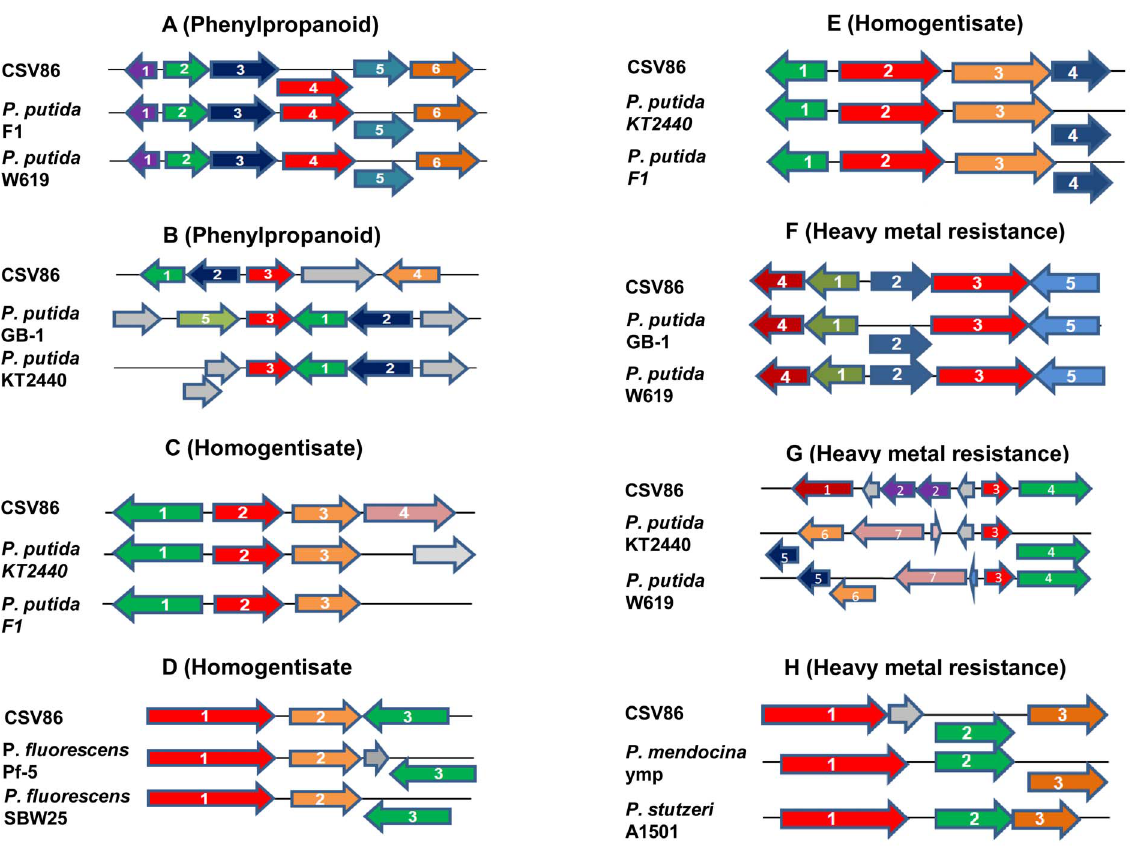
Figure 5. New aromatics degradation pathways genes identified in Pseudomonas putida CSV86 by genome analysis. A–B . Phenylpropanoid pathway genes (Contig 115, 220), C–E . Homogentisate pathway genes (Contig 27, 99, 177), F–H . Copper resistance genes (Contig 19). For details refer to Figures S11, S12, S13. doi:10.1371/journal.pone.0084000.g005 4-HPA in CSV86 were present in contig 7, 120, 175 and 216 (Table S2). There were two copies of each hpaD (contig 7 and 120) and homoprotocatechuate degradative operon repressor gene (contig 7 and 216). The genes present in CSV86 contig 7 were organized as hpaAGEDFHI while, in Pseudomonas fluorescens SBW25 homoprotocatechuate degradative operon repressor gene was present upstream of this hpa cluster (Figure 4F, Figure S9).